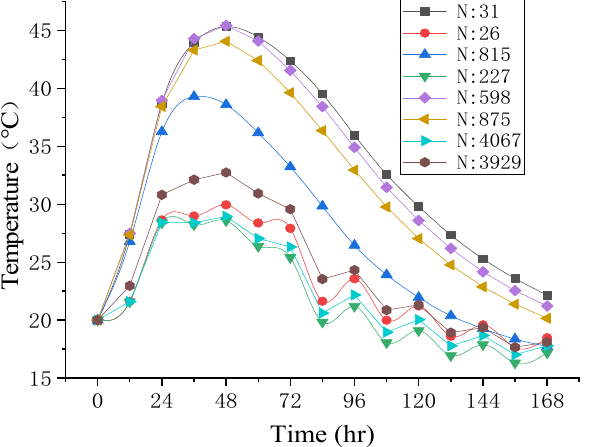
Figure 8. Time–temperature curves of the temperature at each key node of the box girder.